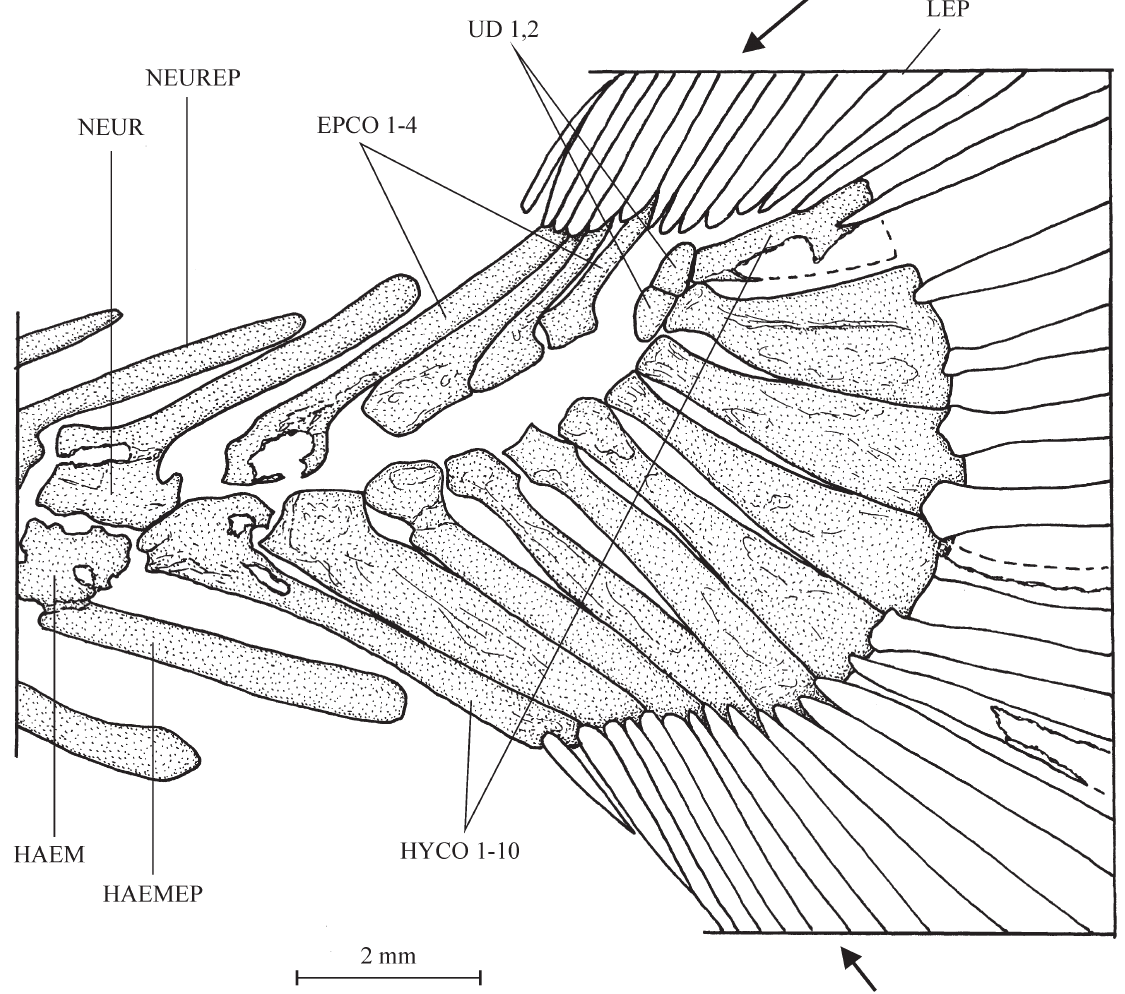
Fig. 16. Acrorhinichthys poyatoi gen. et sp. nov. Caudal skeleton of the holotype CLC S-630a, completed with face b. The arrows point to the most external principal